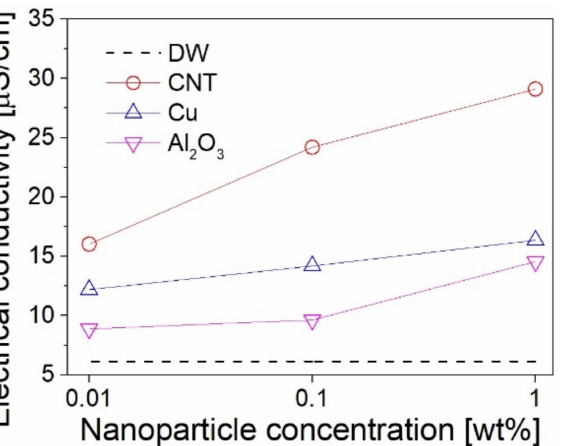
Figure 6. Electrical conductivity measured at 25 ◦ C for three nanofluid groups with three different nanoparticle